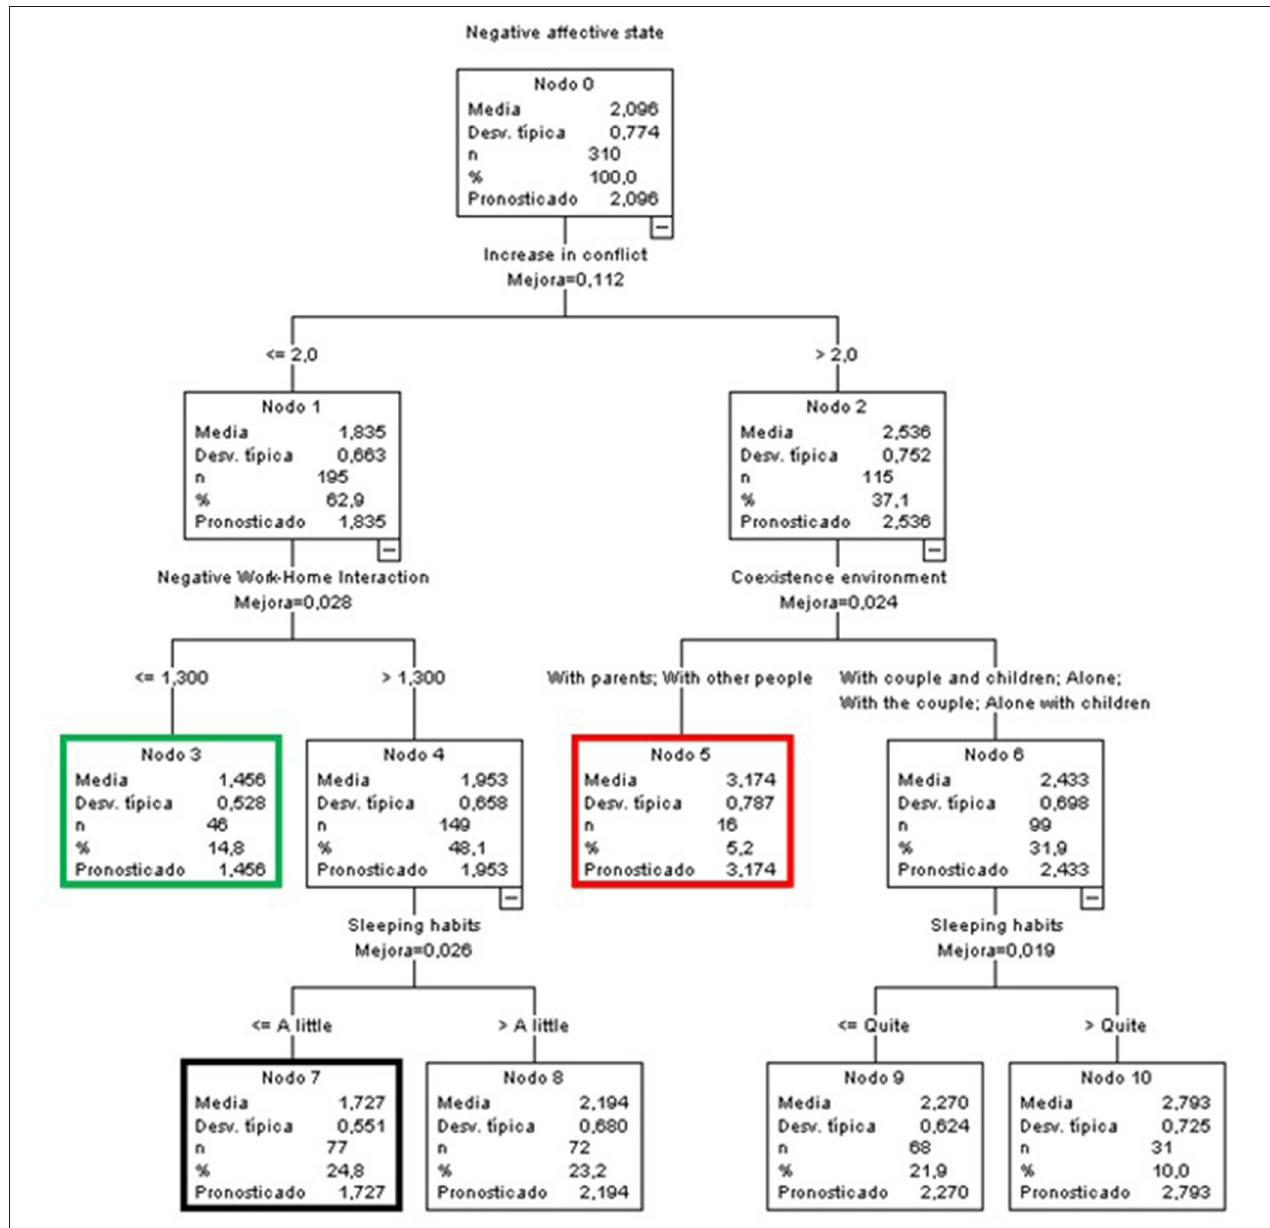
FIGURE 5 | Classificatory tree of negative affective states